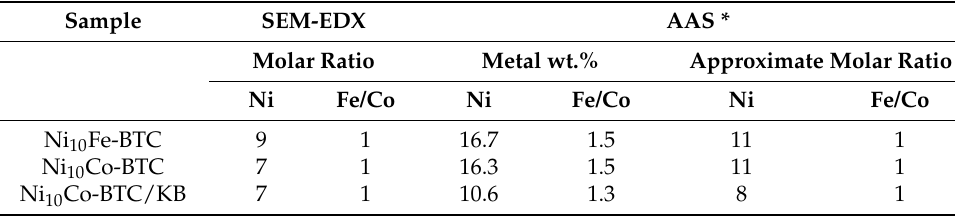
Table 1. SEM-EDX and AAS results of the mixed-metal